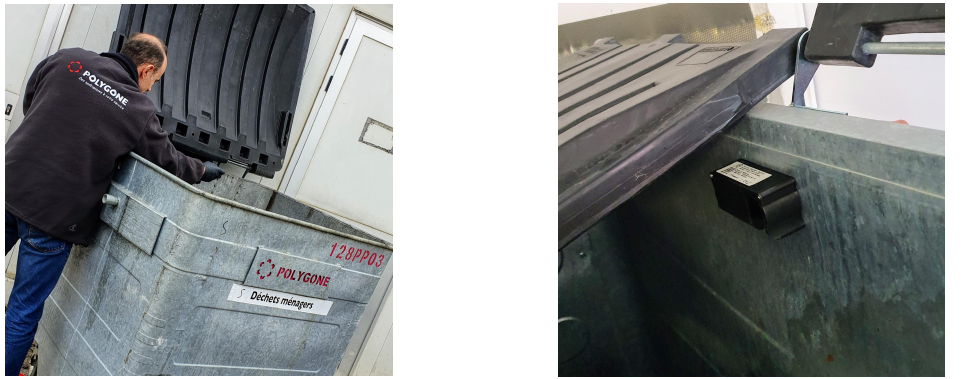
Figure 6. Deployment of one sensor into a